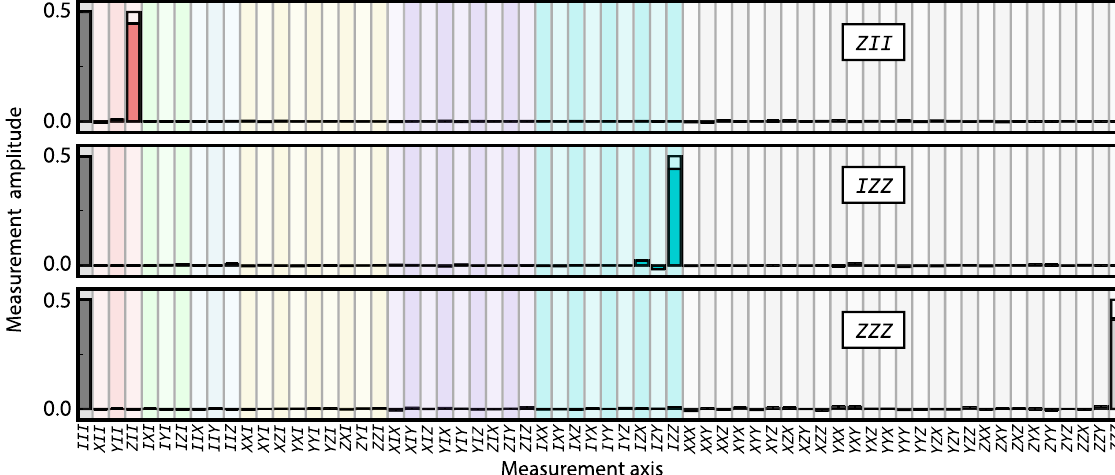
FIG. 4. Results of quantum detector tomography for three selected operators, using the unheralded data sets. We expand the first P σ c element E of each POVM in three-qubit generalized Pauli operators σ , so that E ¼ , and show the magnitudes of the coefficients i i i i of that expansion. For measurement of a Pauli operator, each should have two nonzero bars (amplitude 0.5) corresponding to the identity and the operator of the measurement, σ . Deviations of the identity bar from 0.5 indicate that the meter has some bias in the detector- m outcome distribution. When the amplitude of the σ bar is less than 0.5, it indicates the measurement does not have full contrast along m the desired axis. Finite values of the other bars indicate that our measurement has undesired sensitivity to an extraneous property. The POVM J fidelities for the illustrated operators are 95%, 94%, and 91%, respectively. The other four realized measurement operators, as well as reconstructed POVMs from the success-heralded data set, are provided in the Supplemental Material